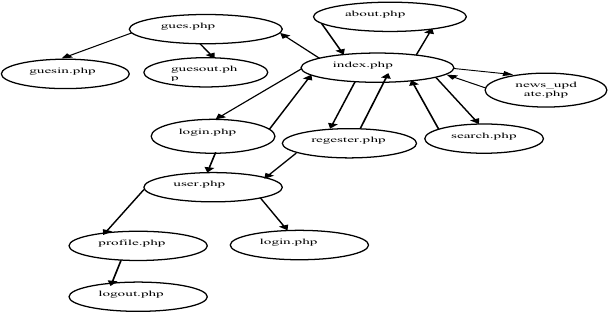
Fig. 3 . Structure presentations of pages in news forum online